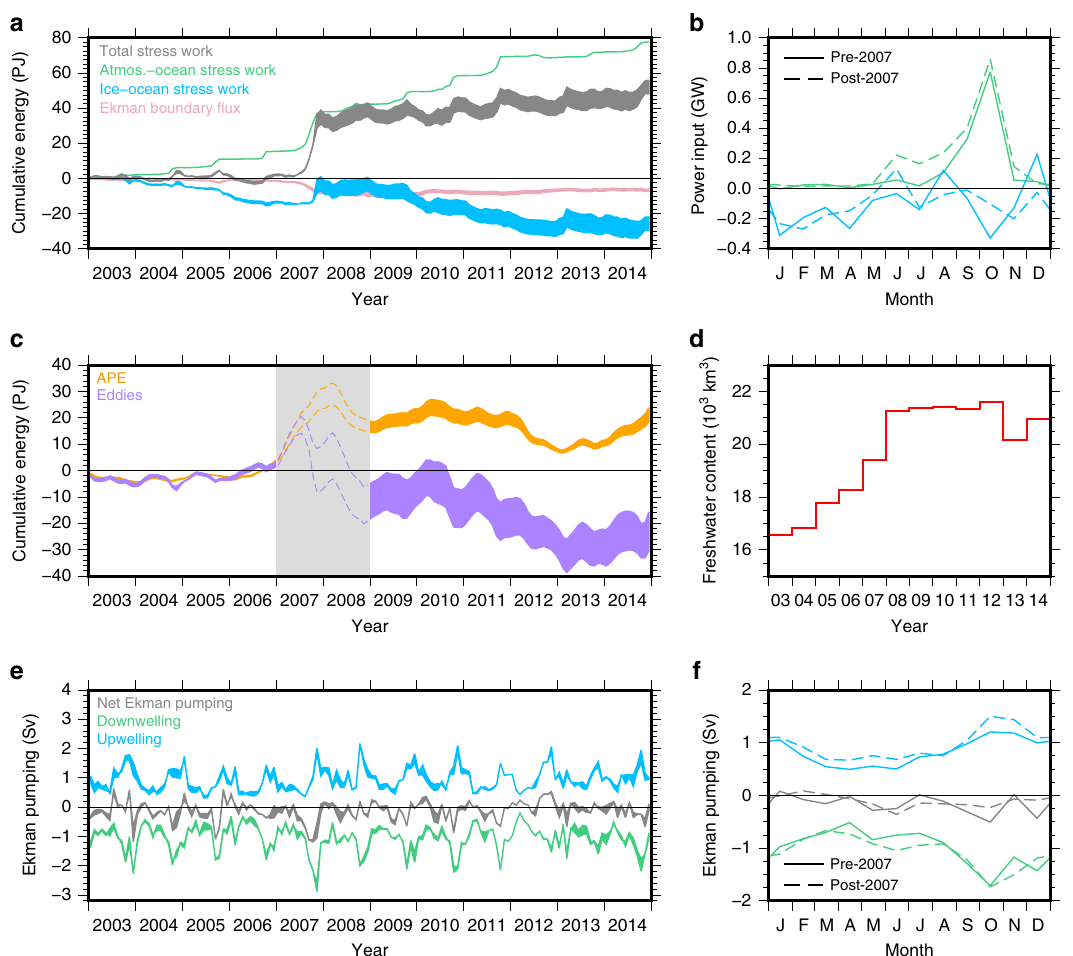
Fig. 2 Beaufort Gyre Energy and Freshwater Budget. a The atmosphere-ocean (green), ice – ocean (blue), and net (atmosphere-ocean + ice-ocean; gray) cumulative energy input to the Beaufort Gyre region (gray), and the boundary thickness fl uxes due to Ekman transport (pink). b The monthly ice – ocean (blue) and atmosphere-ocean (green) seasonal cycle of power input before (solid lines) and after (dashed lines) 2007. c The available potential energy ( APE , orange) and cumulative eddy dissipation (purple) in the Beaufort Gyre region, and d the Beaufort Gyre liquid freshwater content estimates 3 . e The Ekman upwelling (blue), downwelling (green), and net pumping (gray) in the Beaufort Gyre region, and f the seasonal cycle of Ekman pumping before (solid lines) and after (dashed lines) 2007. The gray box in c corresponds to the period when the relationship between DOT and halocline depth breaks down and our estimates of APE and eddy dissipation become unreliable (see “ Methods ” ). The spread on the data in a, e represents the difference in the calculation of wind energy input and Ekman pumping using two different sea ice drift data sets, and the spread in c also incorporates the uncertainty of the fi t between dynamic ocean topography and halocline depth (see “ Methods ”